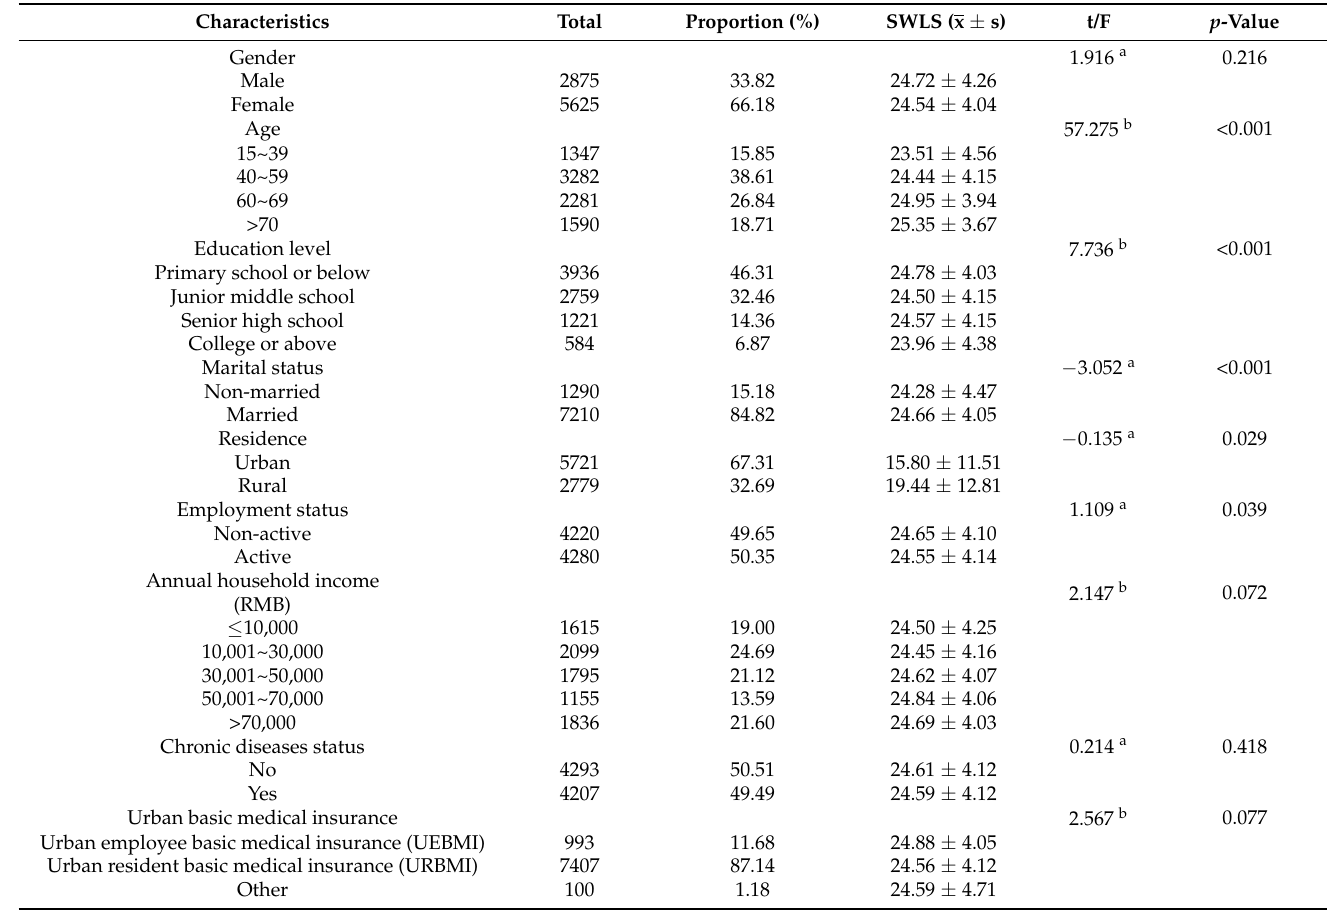
Table 1. Demographic characteristics of residents’ life satisfaction in Taian City, China, (N = 8500).